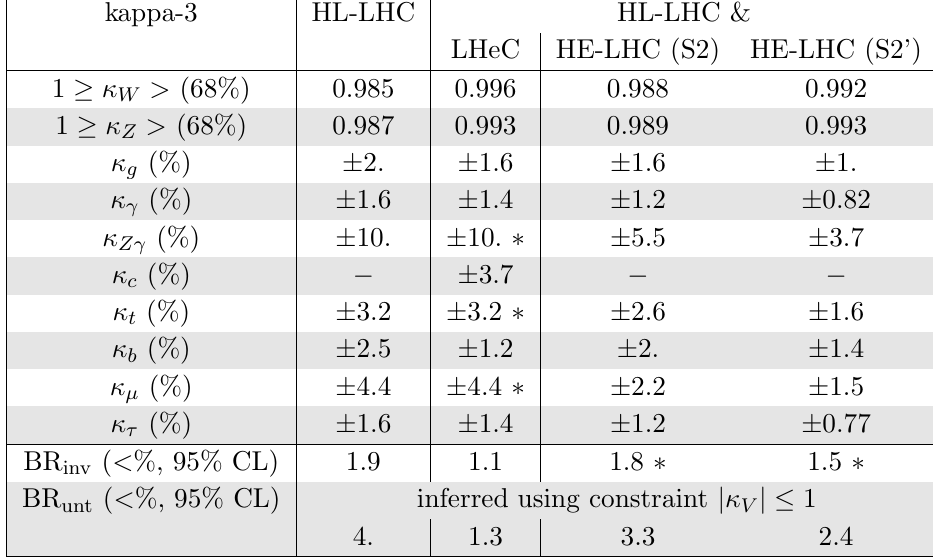
Table 4 . Expected relative precision (%) of the (cid:20) parameters in the kappa-3 scenario described in section 2 for the HL-LHC, LHeC, and HE-LHC. A bound on j (cid:20) V j (cid:20) 1 is applied since no direct access to the Higgs width is possible, thus the uncertainty on (cid:20) W and (cid:20) Z is one-sided. For the remaining kappa parameters one standard deviation is provided in (cid:6) . The corresponding 95%CL upper limit on BR inv is also given. In this kappa-3 scenario BR unt is a (cid:13)oating parameter in the (cid:12)t, to propagate the e(cid:11)ect of an assumed uncertain total width on the measurement of the other (cid:20) i . Based on this constraint the reported values on BR unt are inferred. Cases in which a particular parameter has been (cid:12)xed to the SM value due to lack of sensitivity are shown with a dash ( (cid:0) ). An asterisk (*) indicates the cases in which there is no analysis input in the reference documentation, and HL-LHC dominates the combination. In the case of (cid:20) t sensitivity at the LHeC, note that the framework relies as input on (cid:22) ttH , and does not take into consideration (cid:22) tH . The integrated luminosity and running conditions considered for each collider in this comparison are described in table 1. In the case of HL-LHC and HE-LHC, both the S2 and the S2’ uncertainty models [13] are given for